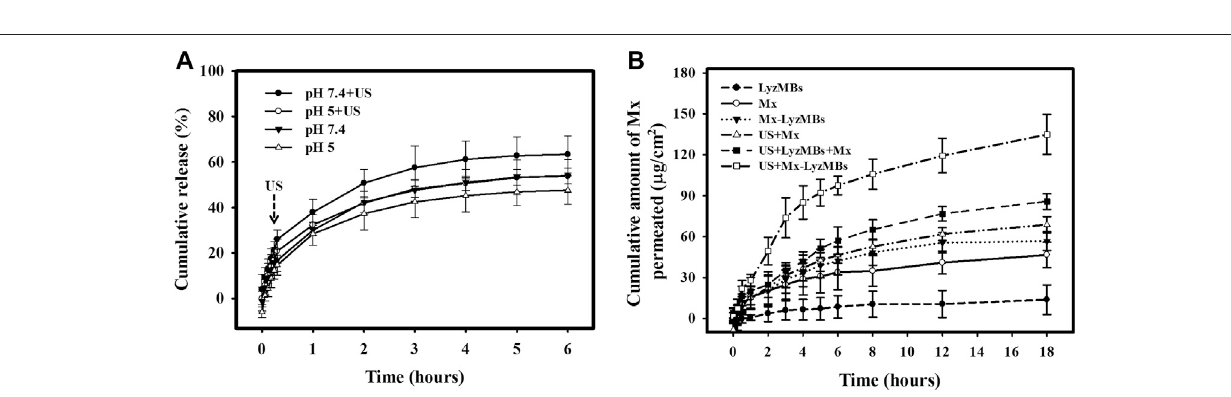
Frontiers in Pharmacology |